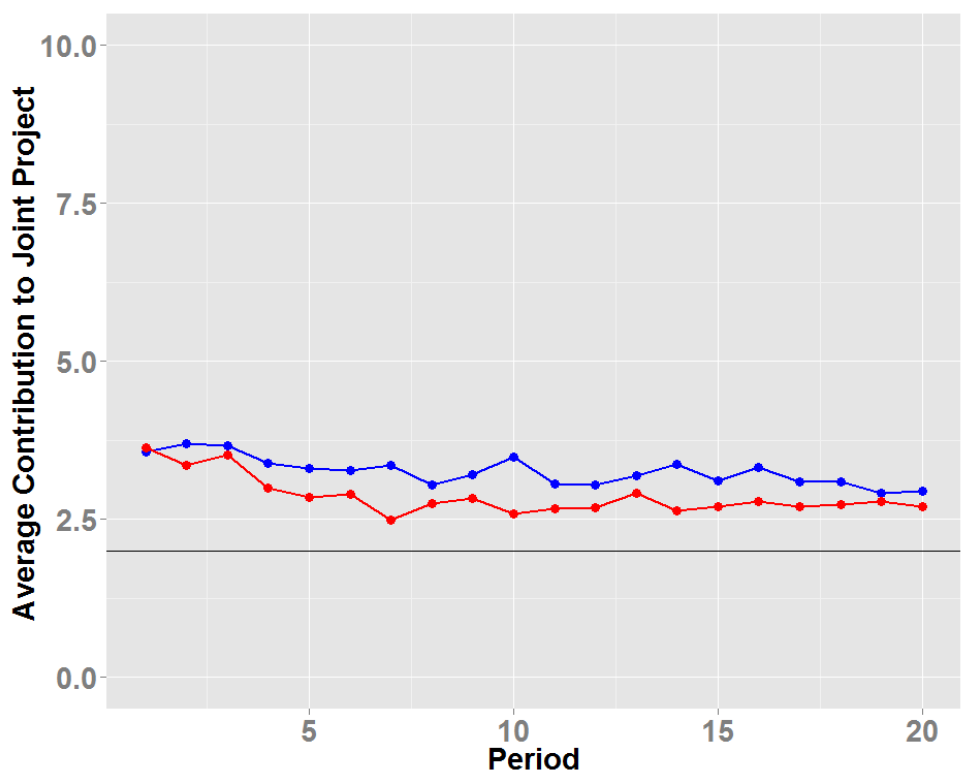
Figure 5. Average contribution to the joint project over 20 periods, linear SCF; n = 5 (blue) and n = 2